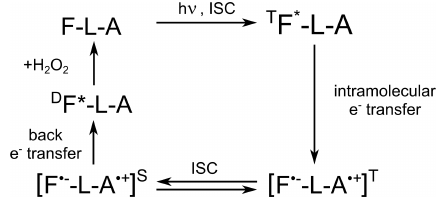
Scheme 1. Cyclic photochemical reaction of reversible intramolec- ular electron transfer from adenine to flavin in FAD molecules in aqueous solution. The triplet–singlet transition in the short-lived flavin–adenine biradical leads to formation of CIDNP. The FAD molecule is shown as F-L-A, where F denotes flavin, L denotes the ribityl phosphate linker, and A denotes